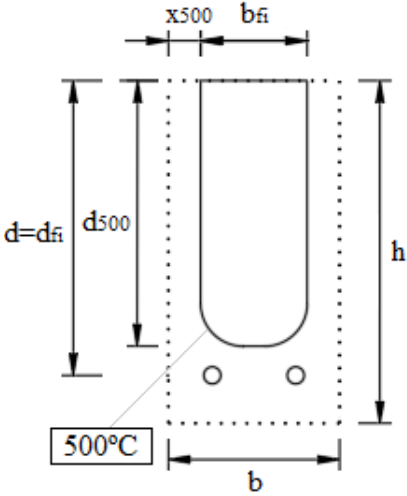
Figure 3. 500ºC Isotherm. (Source: Adapted [11])